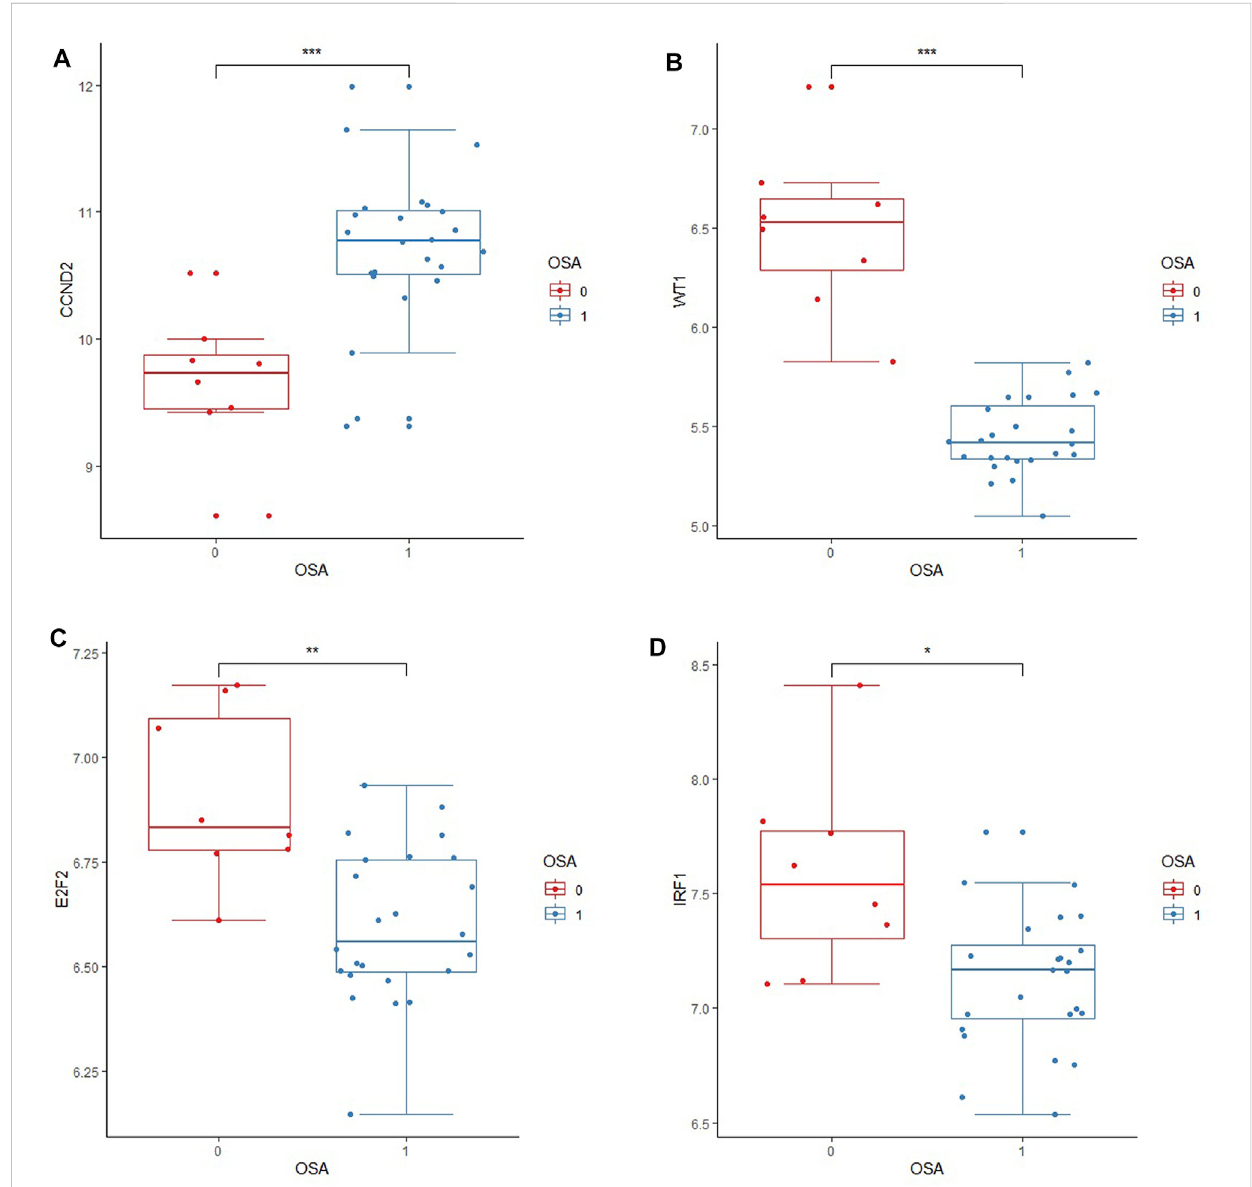
FIGURE 8 Boxplots of differential expression of key genes in the external validation cohort. External validation of four core genes in the GSE135917 dataset. “ 0 ” indicates the normal group; “ 1 ″ indicates the OSA group. OSA stands for Obstructive Sleep Apnea. (A) The relativeexpression level of CCND2 between OSAandnormalgroups; (B) TherelativeexpressionlevelofWT1betweenOSAandnormalgroups; (C) TherelativeexpressionlevelofE2F2betweenOSA and normal groups; (D) The relative expression level of IRF1 between OSA and normal group. Data are presented as medians with interquartile ranges. t -test was used to compare relative expression levels between the two